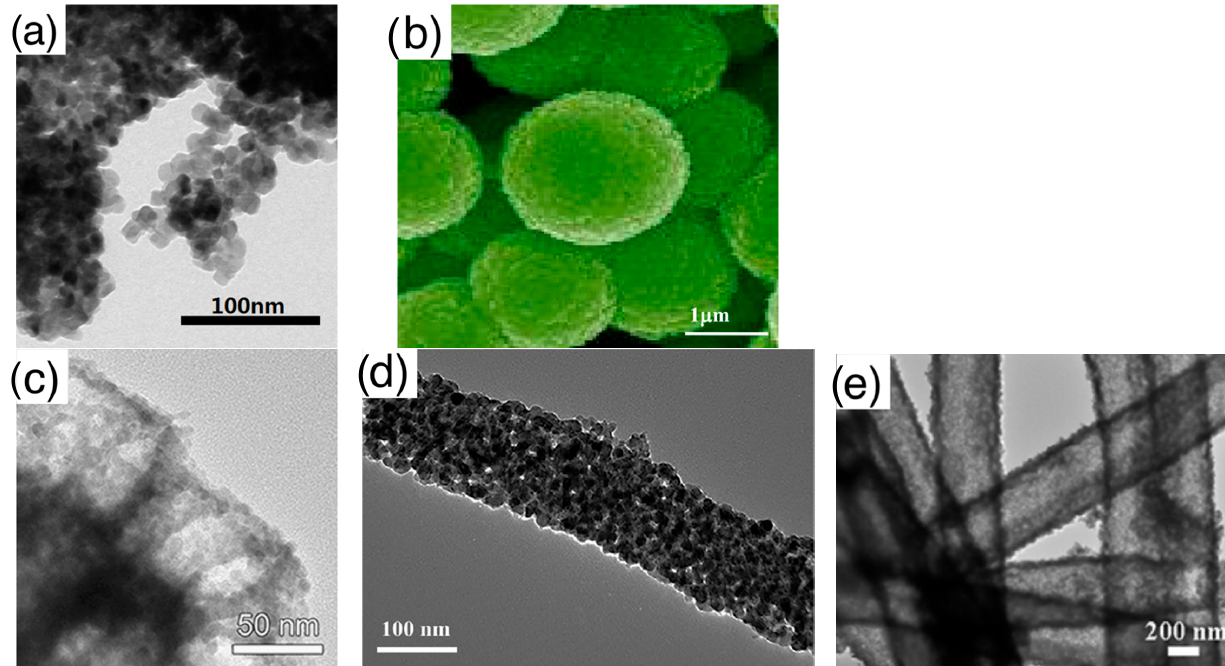
Figure 4. Types of elementary units assemblies (using nanoparticles as elementary building blocks): ( a ) disordered nanoparticles network with no hierarchical organization; ( b ) networks of nanoparticles organized in spherical assemblies; ( c ) nanoparticles organized in porous spheres assemblies, detail of a single porous sphere; ( d ) networks of nanoparticles organized in fiber-like assemblies, zoom over a single fiber; ( e ) networks of nanoparticles organized in porous-fiber assemblies. ( a ) is reprinted from [50] Copyright (2016), with permission from Elsevier; ( b ) is reprinted from [51] Copyright (2013), with permission from Elsevier; ( c ) is reprinted from [52]; ( d ) fiber is reprinted from [53] Copyright (2017), with permission from Elsevier; ( e ) is reprinted from [54] Copyright (2015), with permission from Elsevier. Overall, the statistical results reported in Section 4 are retrieved based on 121 pure SnO 2 materials reported in 85 literature articles, whose distribution between the consid- ered morphological classes is summarized in Table 1 , together with the lists of the respec- tive references. The statistics is highly inhomogeneous with respect to crystallites’ shape and hierarchical assembly. Though the mentioned inhomogeneity may be undesired from a statistical point of view, it is anyway a matter of fact reflecting the larger amount of studies that have been dedicated in the considered period of time to a given morphology with respect to another. Table 1. Number of different materials (elementary building blocks and their eventual hierarchical organization) whose experimental responses to ethanol have been used for the statistical analysis reported in Section 4. For each morphological type, in addition to the number of materials, the related references are also listed. Type of Assembly\Building Blocks Nanoparticles